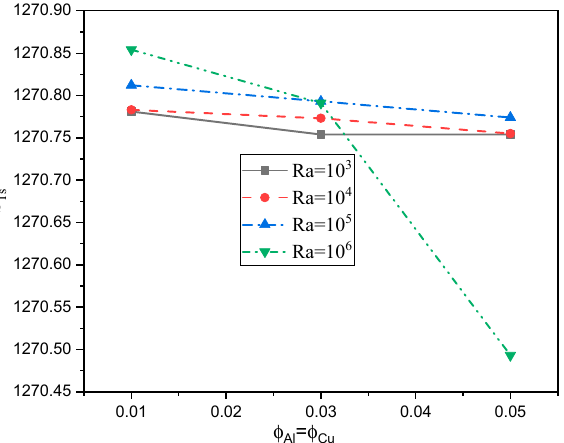
Figure 12. Profiles of the S TS of the solid phase in the entire domain for the variation of the Rayleigh number and nanoparticle volume fraction φ Al = φ Cu at Ha = 15, H = 0.1, γ = π /6, Φ = π